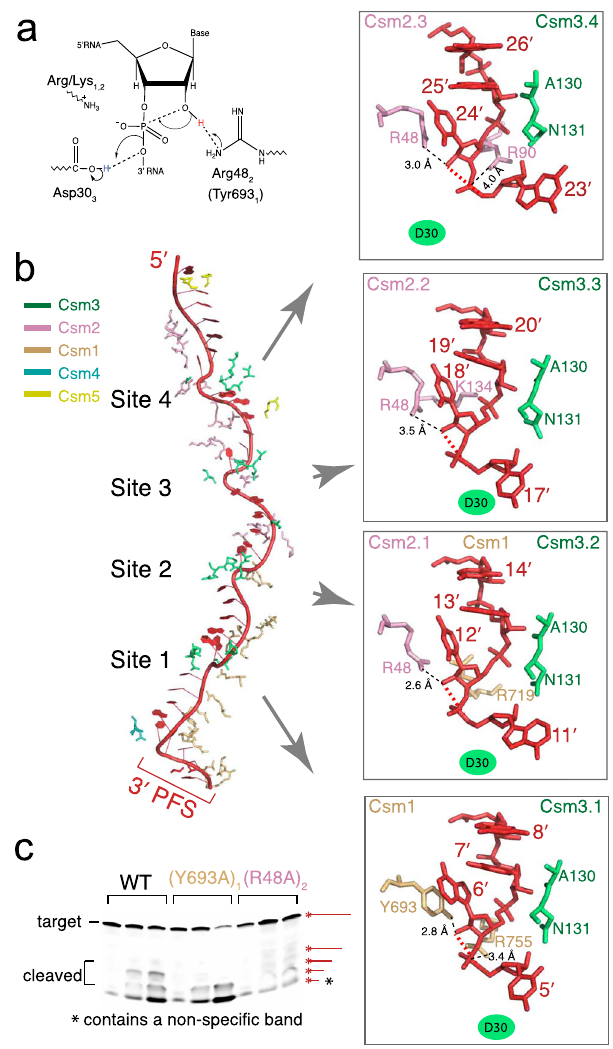
Fig. 5 Structures of the four target RNA cleavage centers. a A possible reaction mechanism mediated by the conserved Csm3 (Asp30) and Csm2 (Arg48) residues. b Each cleavage center is superimposed and displayed in close-up view at the same orientation in the inset. The residues of Csm1, Csm2, and Csm3 surrounding the cleavage sites are shown in stick models using the same color scheme as in structural models and labeled. The mutated Asp30Ala (Csm3) is shown as a fi lled oval. Upon binding to the crRNA, target RNA undergoes base fl ipping every 6th nucleotide at the four cleavage sites (sites 1 – 4), forming an inline geometry involving the 2 ’ - nucleophile oxygen, the scissile phosphate, and the 5 ′ -leaving oxygen atoms. c In vitro cleavage results with 5 ′ Cy3-labeled target RNA. Possible products are indicated by starred red lines. A non-speci fi c product is indicated by a